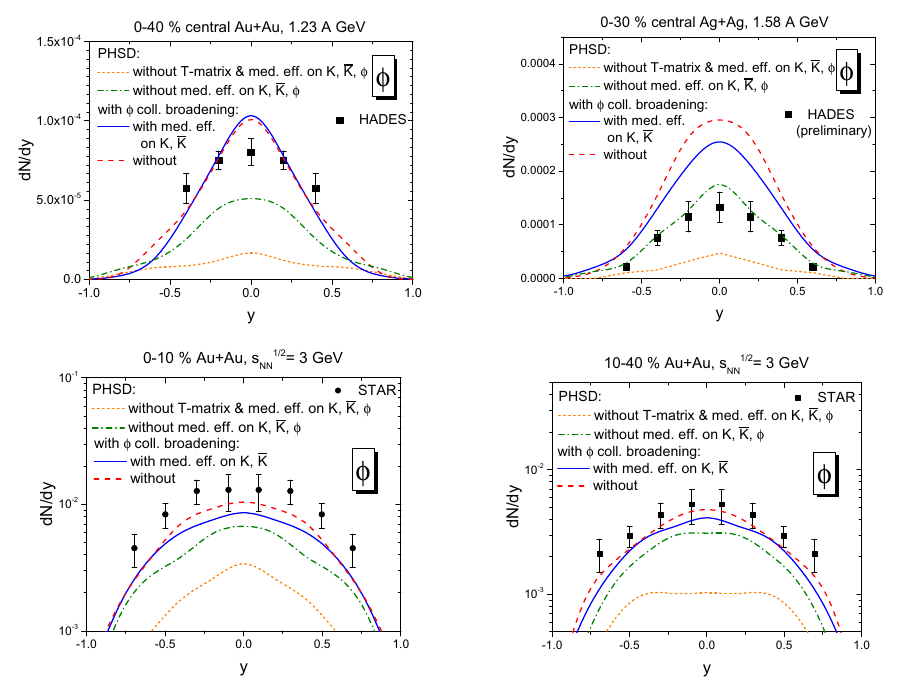
Figure 1. Rapidity distribution of reconstructed φ mesons in 0-40 % central Au + Au collisions at E kin = 1.23 A GeV, in 0-30 % central Ag + Ag collisions at E kin = 1.58 A GeV and 0-10 % and 10-40 % central Au + Au collisions at √ s NN = 3 GeV, compared with experimental data from the HADES and STAR collaborations [1, 4, 16]. Each colored line is explained in the